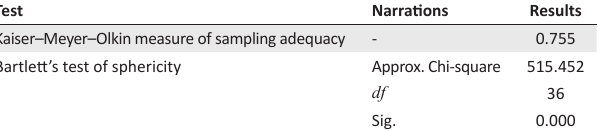
TABLE 7: Principal component analysis for financial literacy. Test